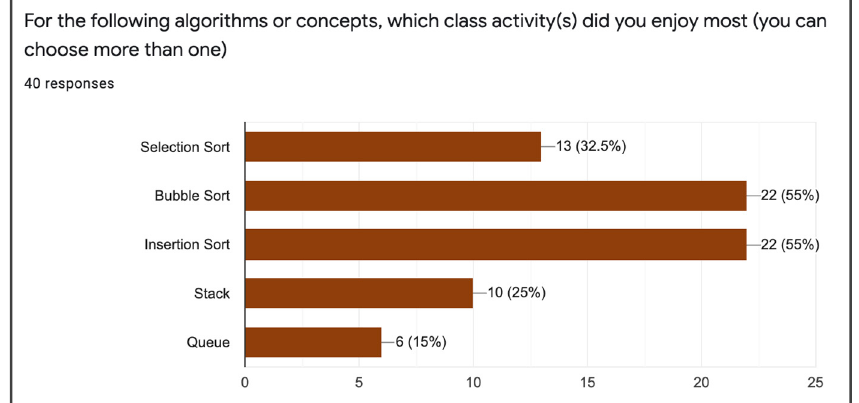
Figure 14. Students’ enjoyment of different activities.